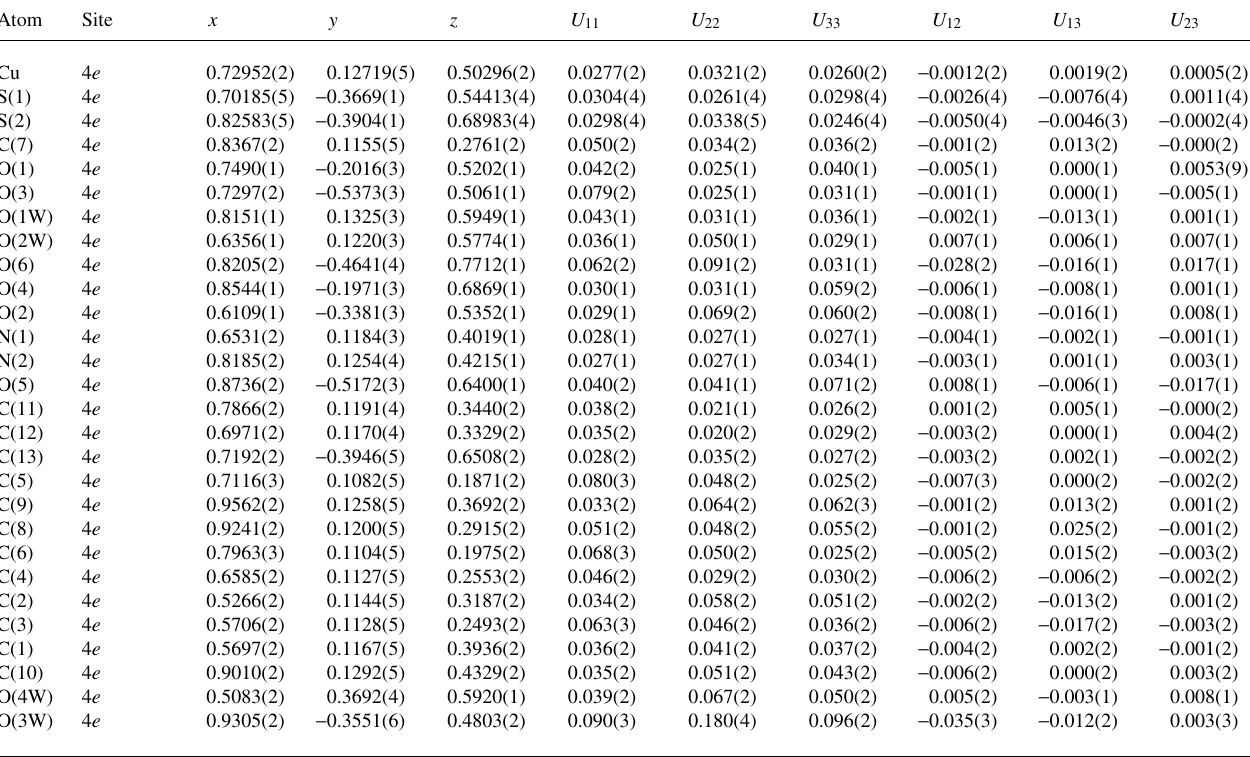
Table 3. Atomic coordinates and displacement parameters (in Å 2 )